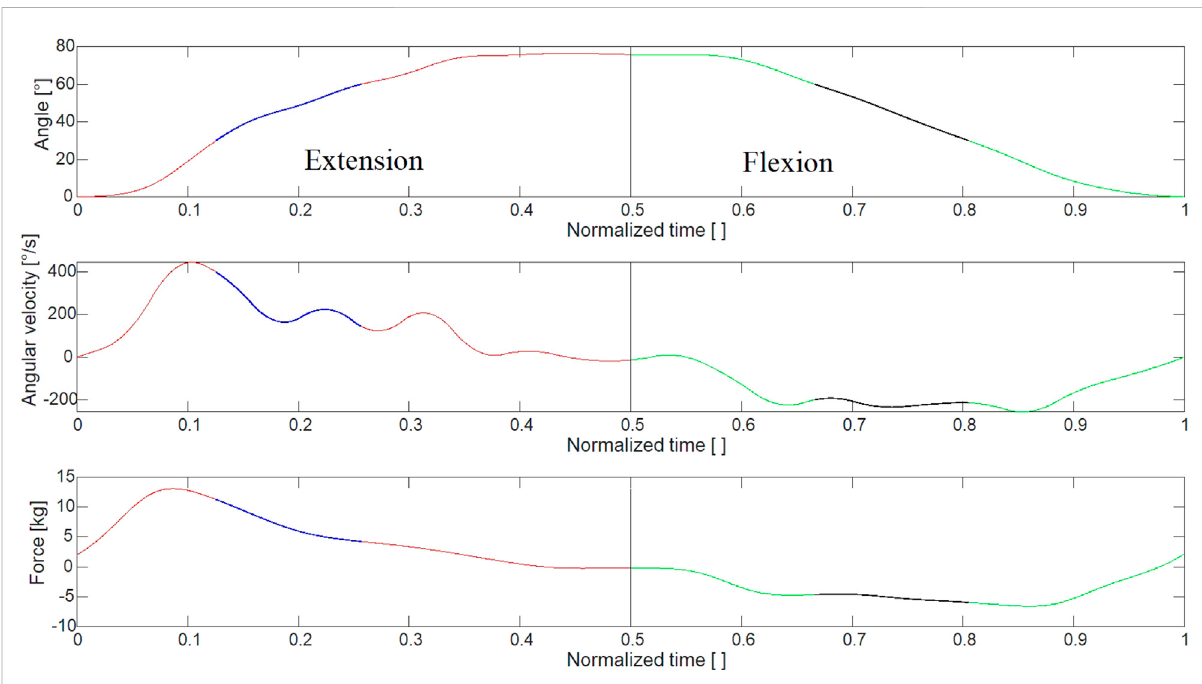
FIGURE 5 Single cycle showing the region where the average load is acting within the swing during extension of the knee (blue) and fl exion (black).